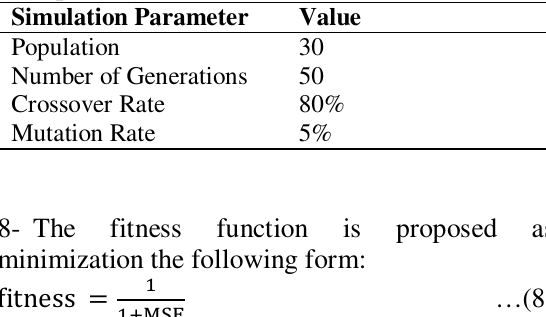
The specifications of GA